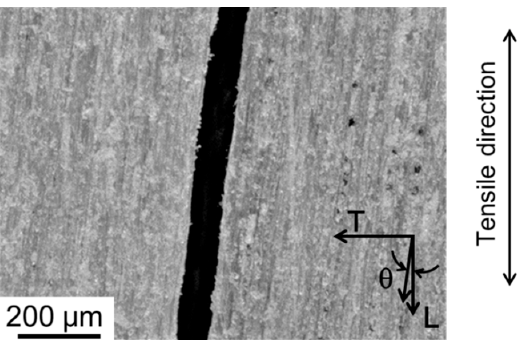
Figure 13. A single shear crack path in the shear fracture observed in the L-T plane.